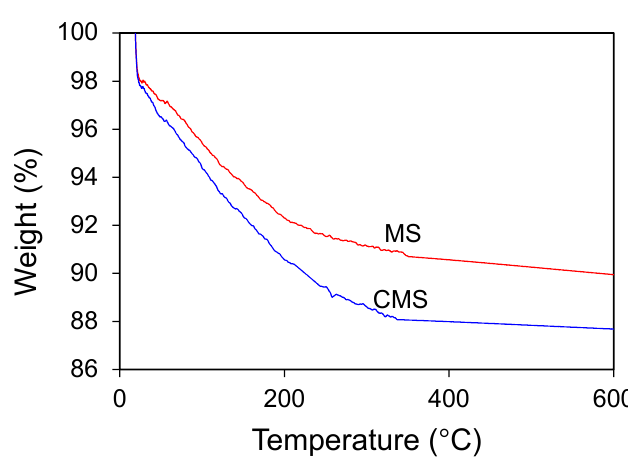
Figure 4. XRD patterns of MS and CMS.